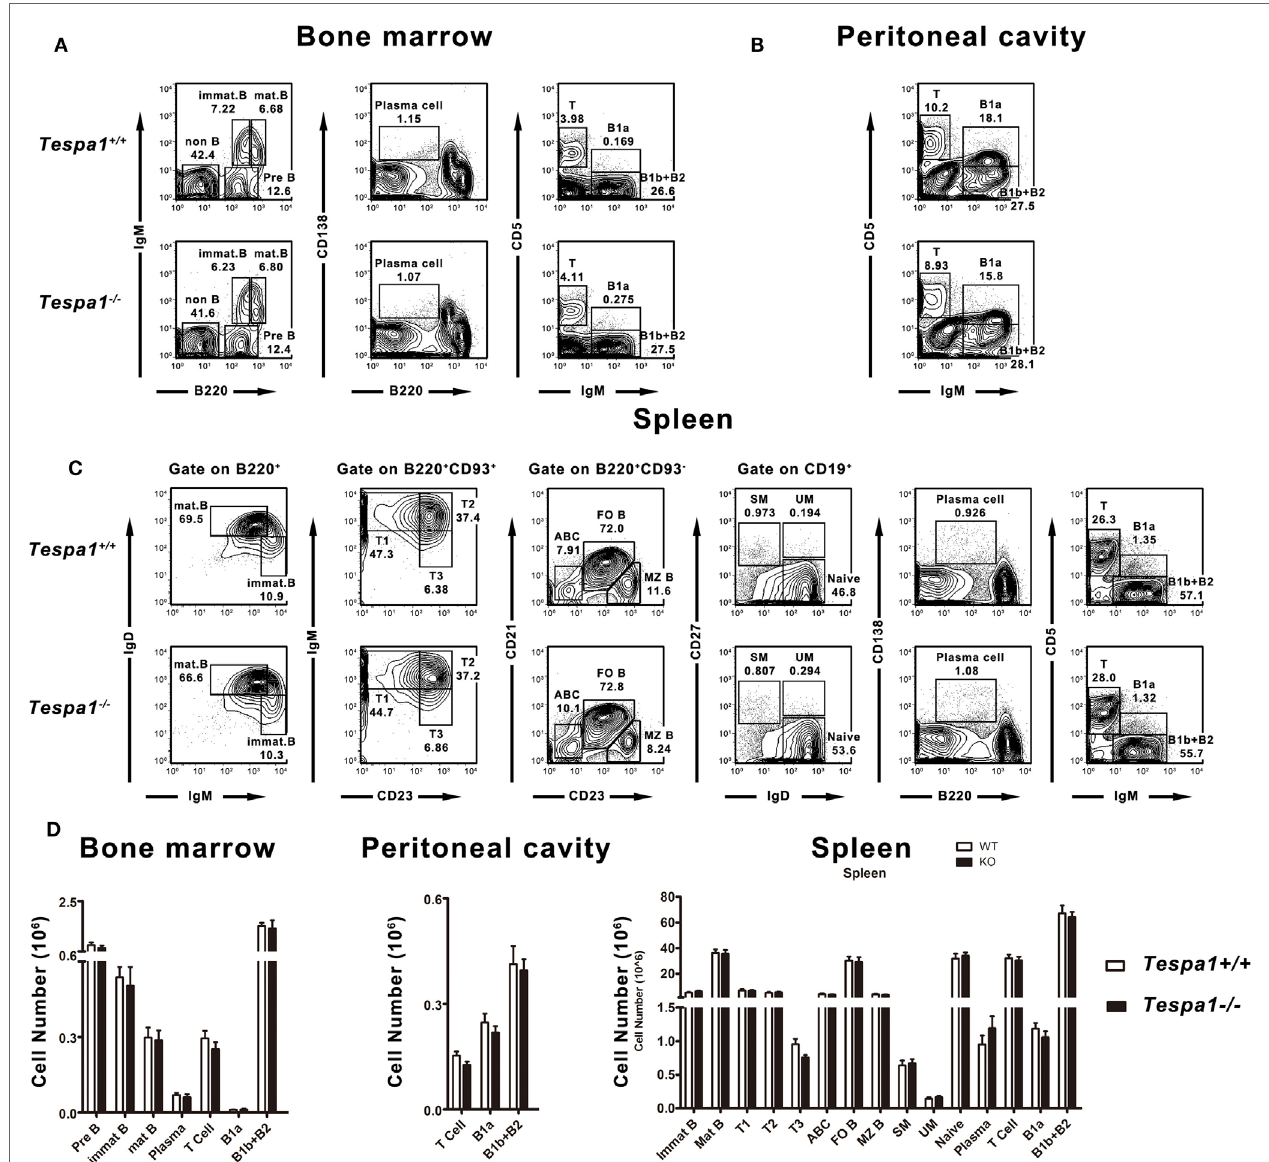
FigUre 1 | Normal B cell development in Tespa1 -deficient mice. FACS profiles of B cell subsets present in (a) bone marrow, (B) peritoneal cavity, and (c) spleen of Tespa1 -deficient and wild-type control mice. (D) Numbers and percentages of B cell subsets in the indicated organs of Tespa1 -deficient and WT mice. Data represent five mice per group. Similar results were obtained in three independent